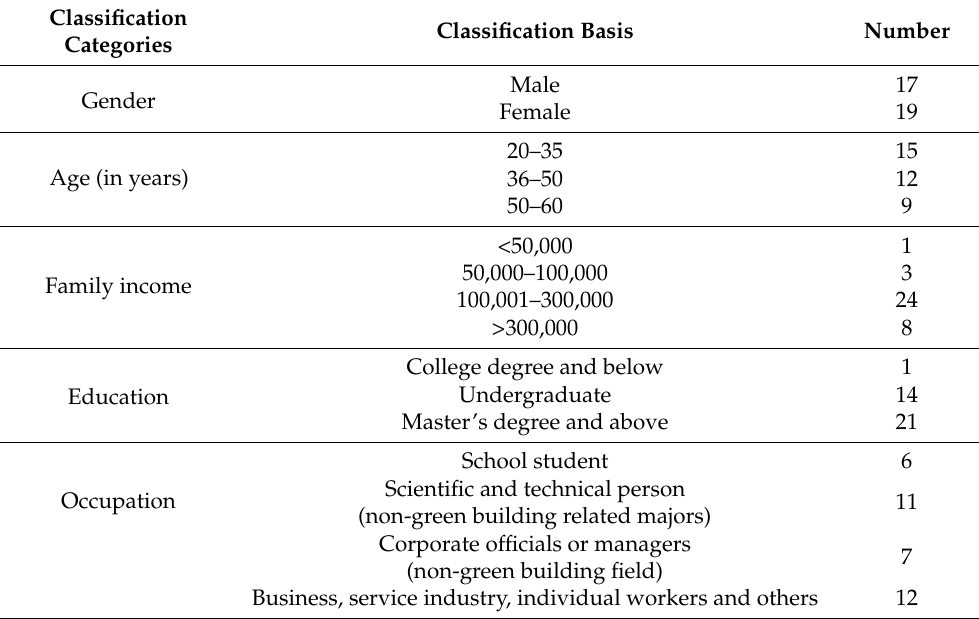
Table 1. Basic information of